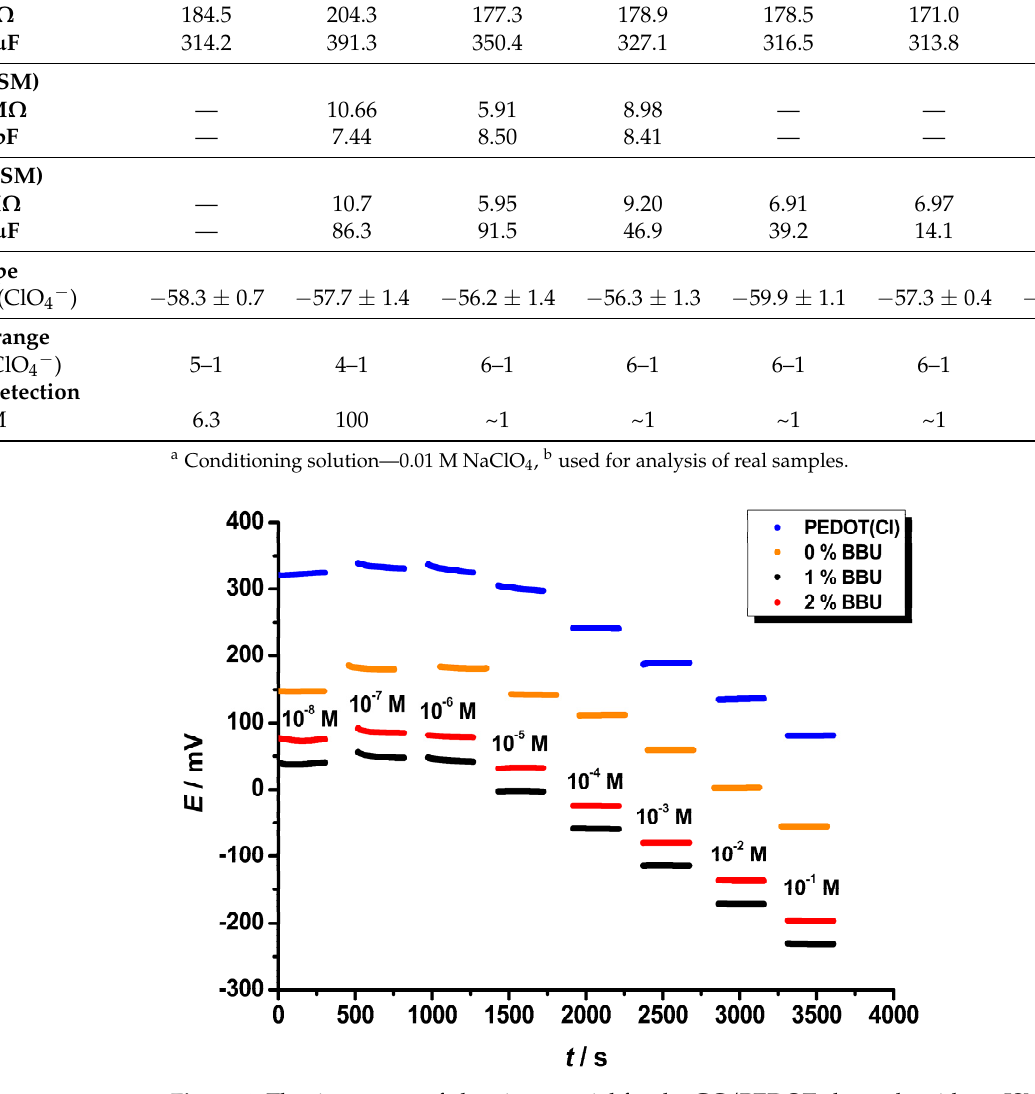
Figure 4. The time traces of electric potential for the GC/PEDOT electrode without ISM (blue) and the GC/PEDOT/ISM electrodes with ISMs containing 0% BBU (orange), 1% BBU (black), and 2% BBU (red), corresponding to electrodes 1–4 (Table 2). The potential of the ISE with ISM containing 0% BBU (orange) was shifted with constant value (+100 mV) for the sake of clarity.